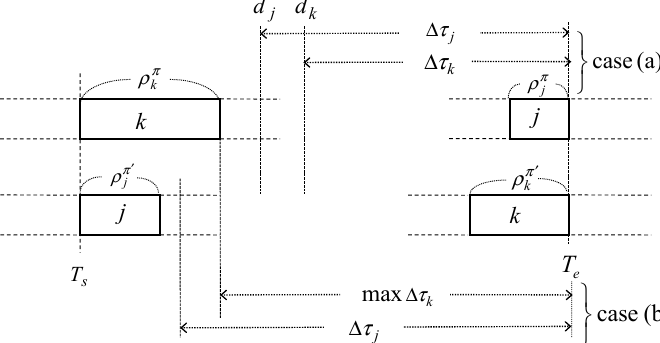
Figure 2. The effect of interchanging two orders in an order sequence. Figure 2. The e ff ect of interchanging two orders in an order